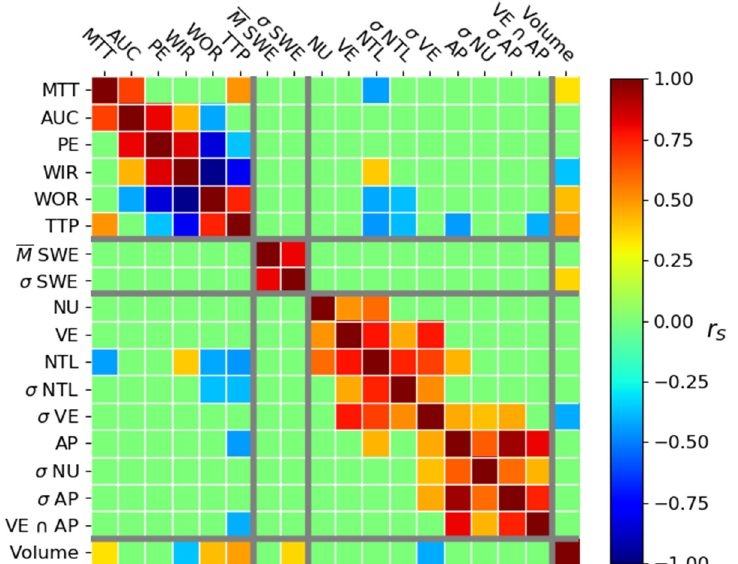
Figure 4. Spearman correlation coefficient value between the CEUS parameters (Mean Transit Time (MTT), Area Under the Curve (AUC), Peak Enhancement (PE), Wash-In Rate (WIR), Wash-Out Rate (WOR), and Time to Peak (TTP)), SWE parameters, histological parameters (percent area occupied by nuclei (NU), the number of T Lymphocytes per mm² (NTL), the percent area of apoptosis (AP), and percent area of vascular endothelium (VE), and co-localization of a high VE and AP (VE ∩ AP)), and tumor volume. Only significant correlations are shown ( p < 0.05).